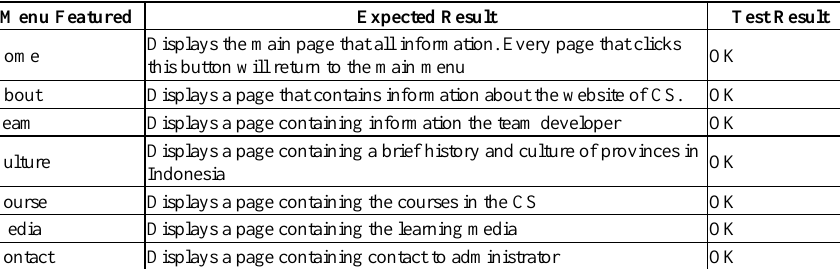
Table 2. Black box testing results on the website the CS